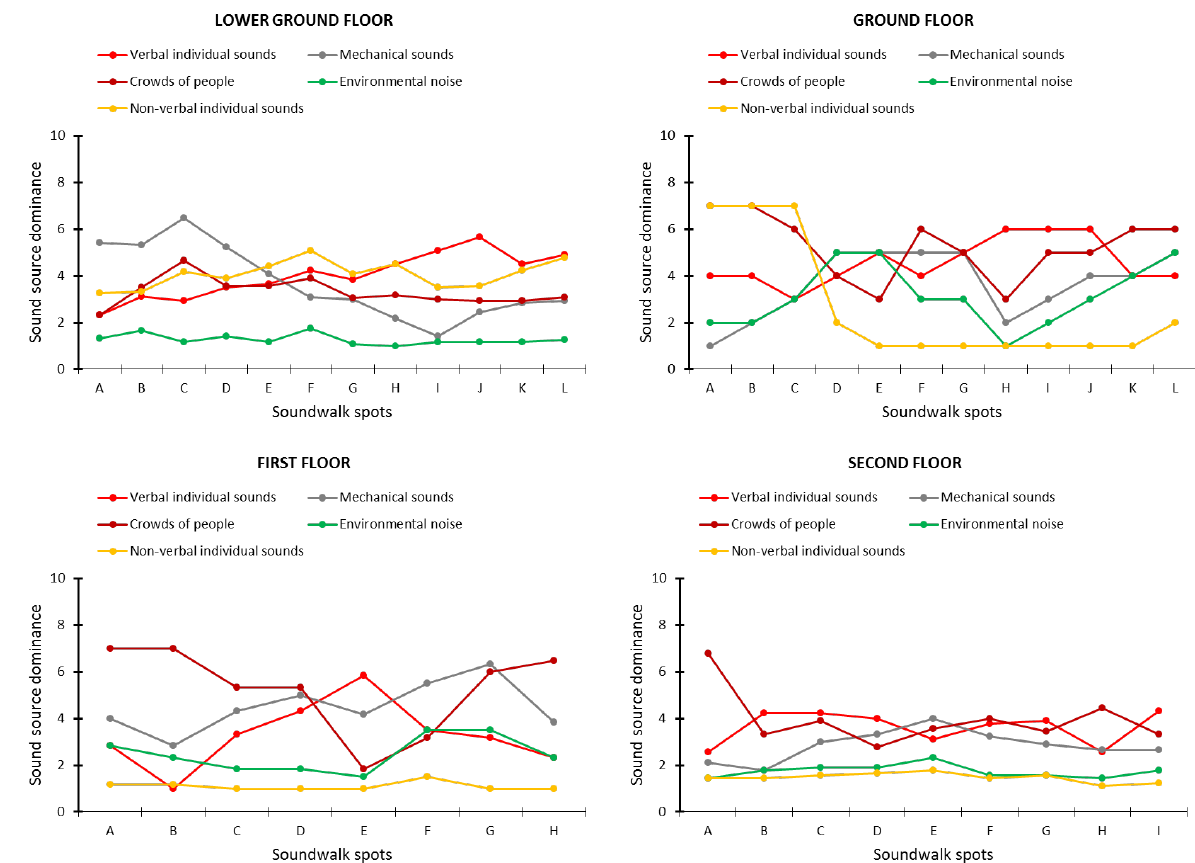
Figure 4: Dominance of sound sources detected during the soundwalk on each.